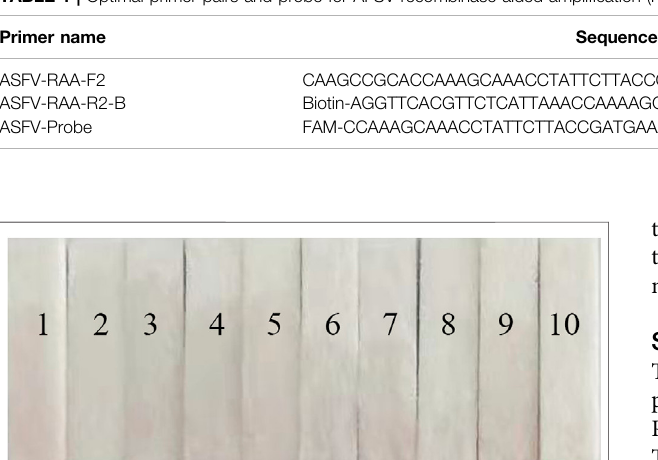
TABLE 1 | Optimal primer pairs and probe for AFSV recombinase aided ampli fi cation (RAA).